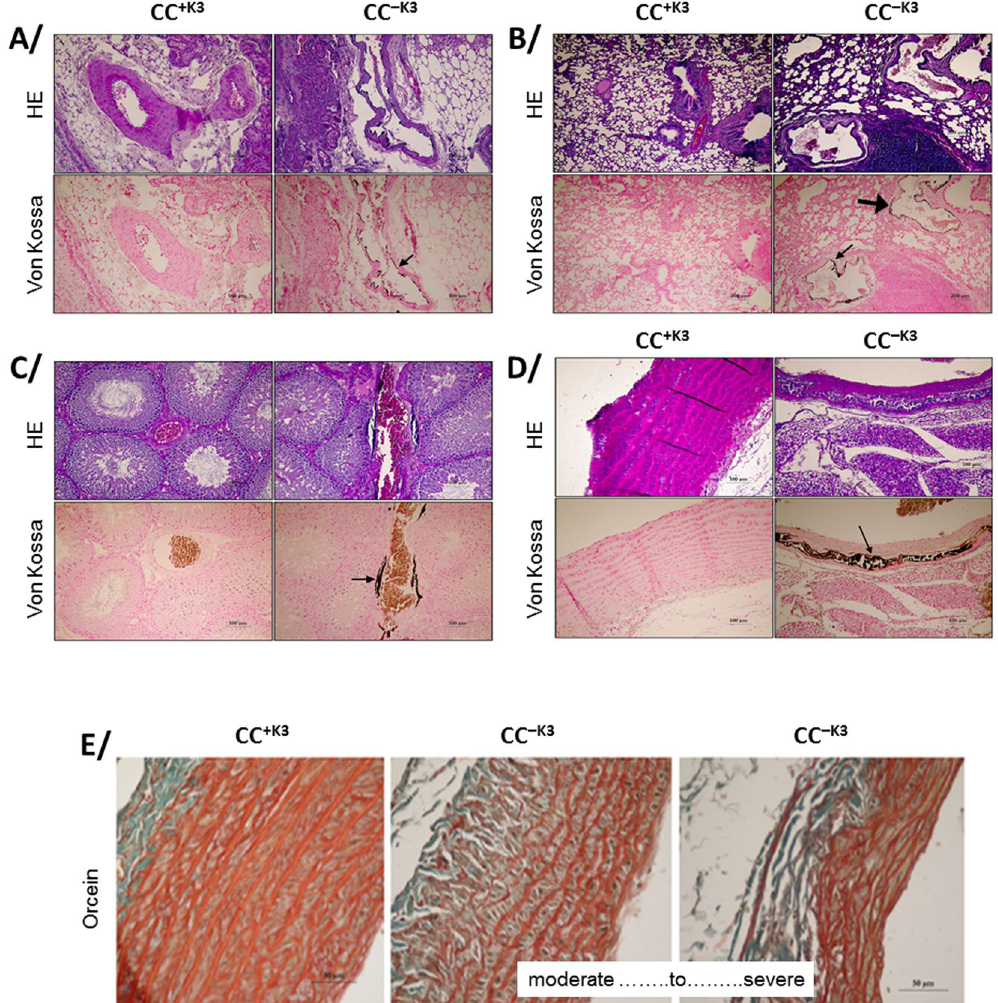
Figure 4. Von-Kossa, hematoxylin-eosin (HE) and orcein staining of various tissues of CC rats feed with (CC + K3 ) or without (CC − K3 ) vitamin K 3 during 12 weeks. A/ kidney, B/ lung, C/ testis, D and E/ aortic cross. Black arrow points out